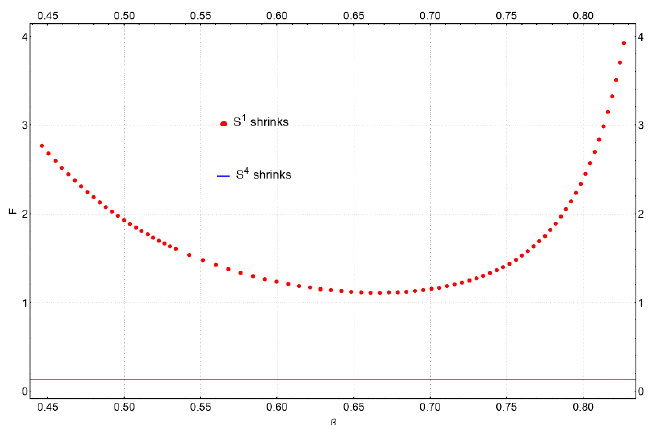
p Figure 12 . NF ( (cid:12) ) =(cid:31) for the solutions with shrinking S 1 , S 4 warp factors. (cid:12) is measured in units of (cid:12) H